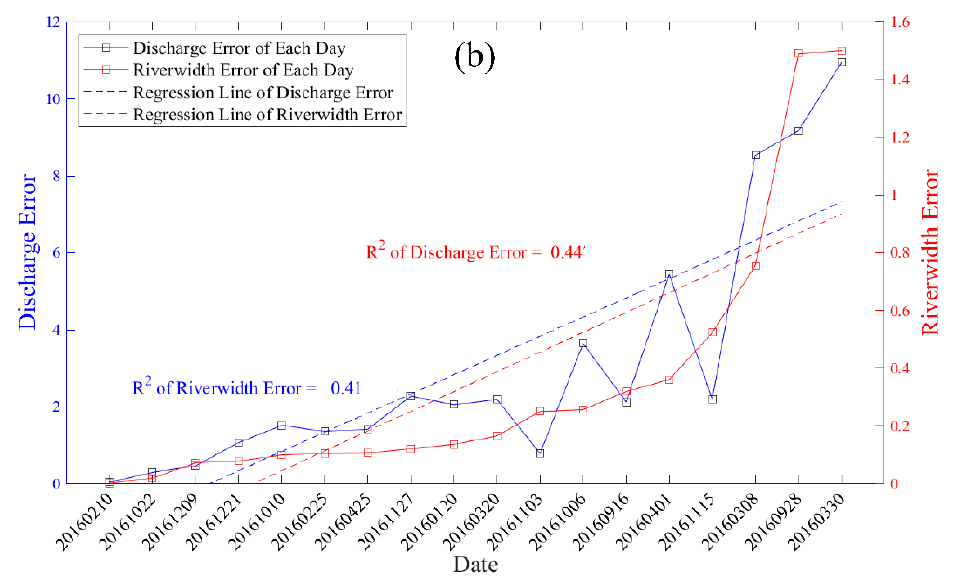
Figure 6. Influence of river width error on flow error in ( a ) flood and ( b ) non-flood season. The solid blue line is flow error, the blue dotted line is its fitting line, the solid red line is river width error, and the dotted red line is its fitting line.